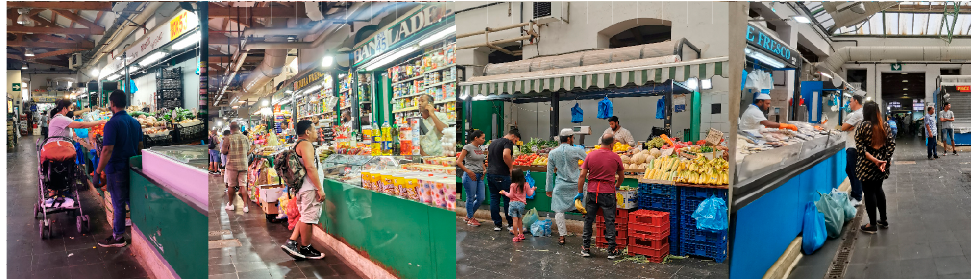
Figure 3. Moments of commercial activity in the market (13 September 2022). © Sharon Mendonce.